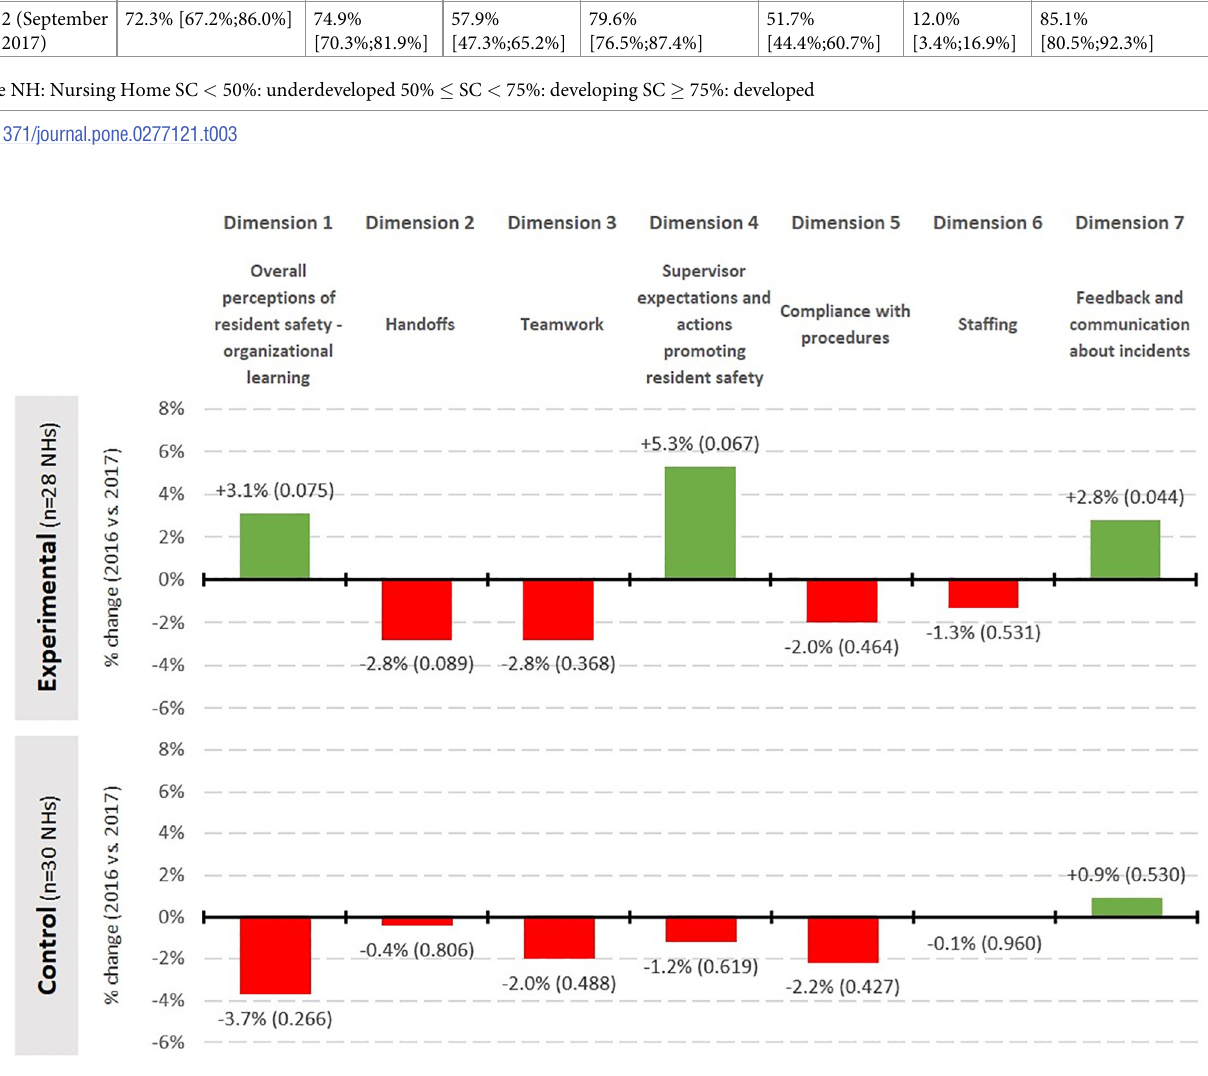
Fig 2. Change in SC scores between 2016 and 2017 for each dimension and for each